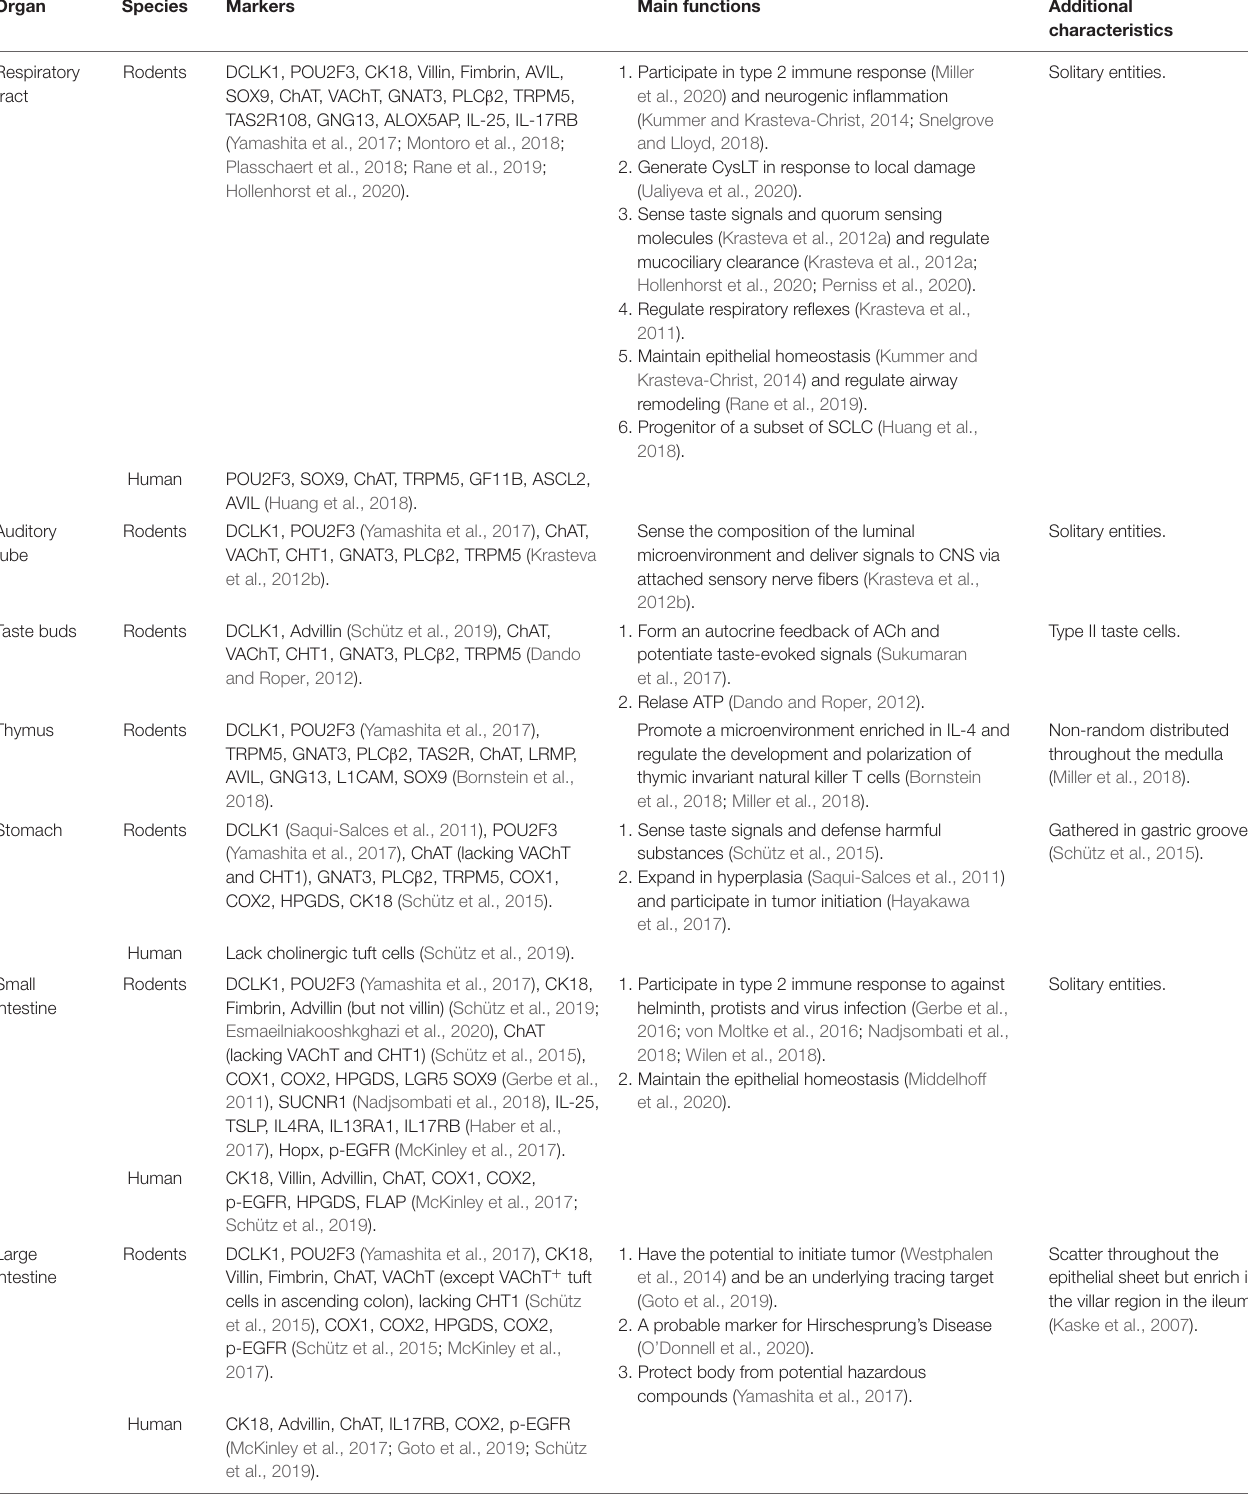
TABLE 1 | Markers and main functions of tuft cells from different